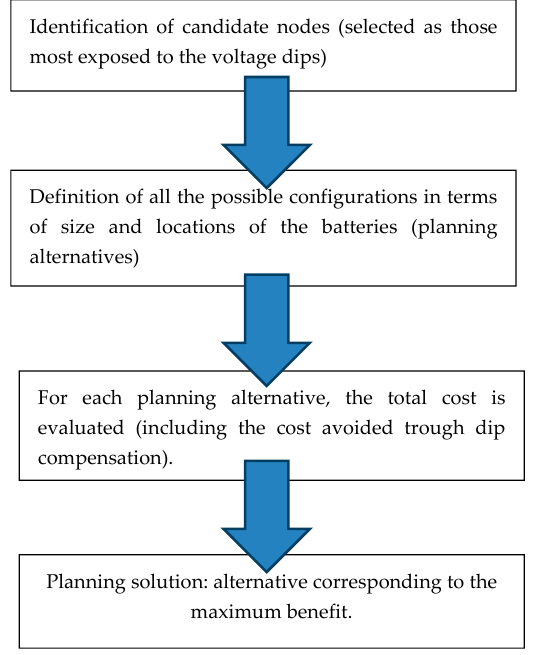
Figure 1. Flow chart of the proposed planning procedure.